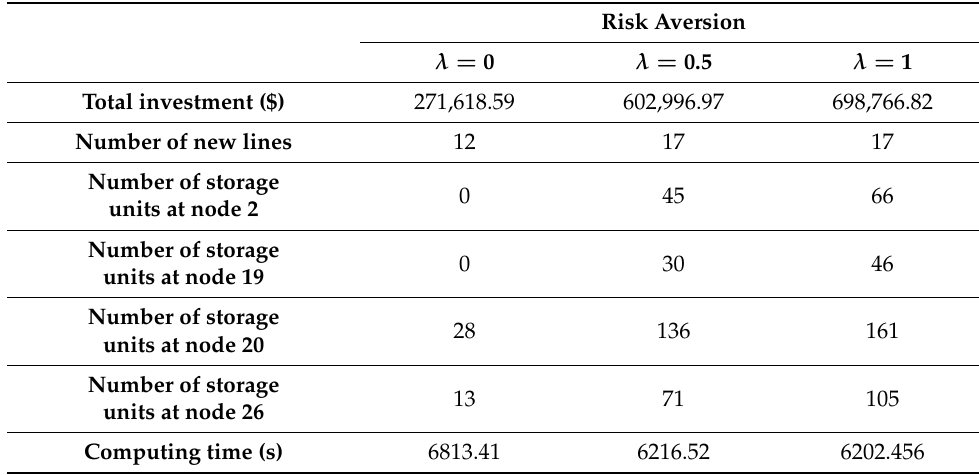
Table 1. Obtained expansion plans.